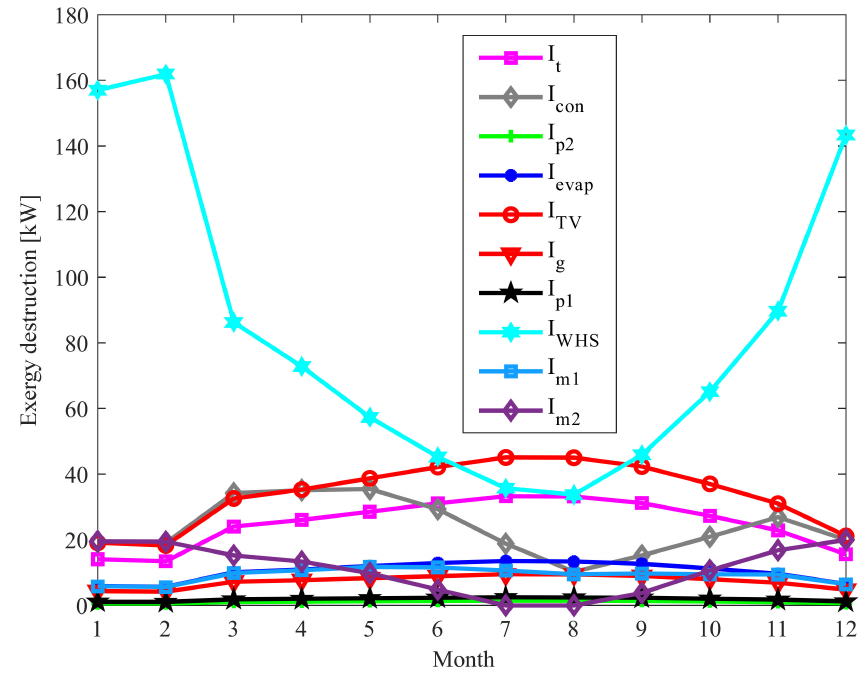
Figure 18. Monthly exergy destruction of each